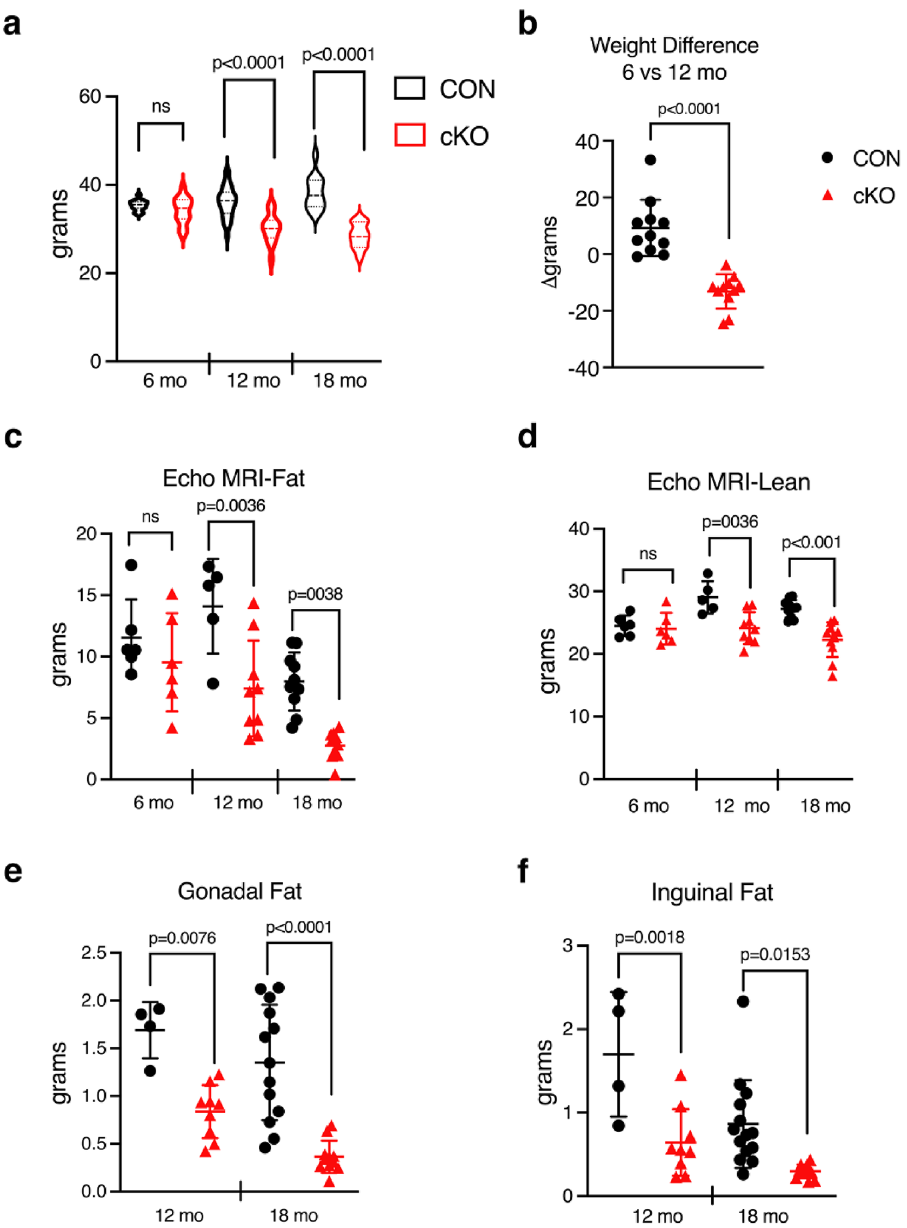
Figure 3. IKKα cKO mice have attenuated weight gain, lower total fat, and less lean mass with age. ( a ) Body weights at 6 mo (n = 15–16), 12 mo (n = 28–31), 18 mo (n = 11–13). (b) Weight change (%) from 6 to 12 mo (n = 11). EchoMRI measurement of ( c ) total fat mass and ( d ) total lean mass at 6mo (n = 6), 12mo (n = 5–9), 18mo (n = 10–11). ( e ) Gonadal and ( f ) Inguinal fat pad weights at 12 mo (n = 4–9) and 18 mo (n = 11–14). Data are represented as mean ± SD, all male mice. CON = black, cKO = red. Student’s, unpaired, two-tailed t-test (for b) or 2-way ANOVA followed by Sidak multiple comparisons test (cross genotype comparisons): ns – non-